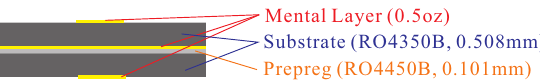
Figure 5. laminate layer definition of the fabricated